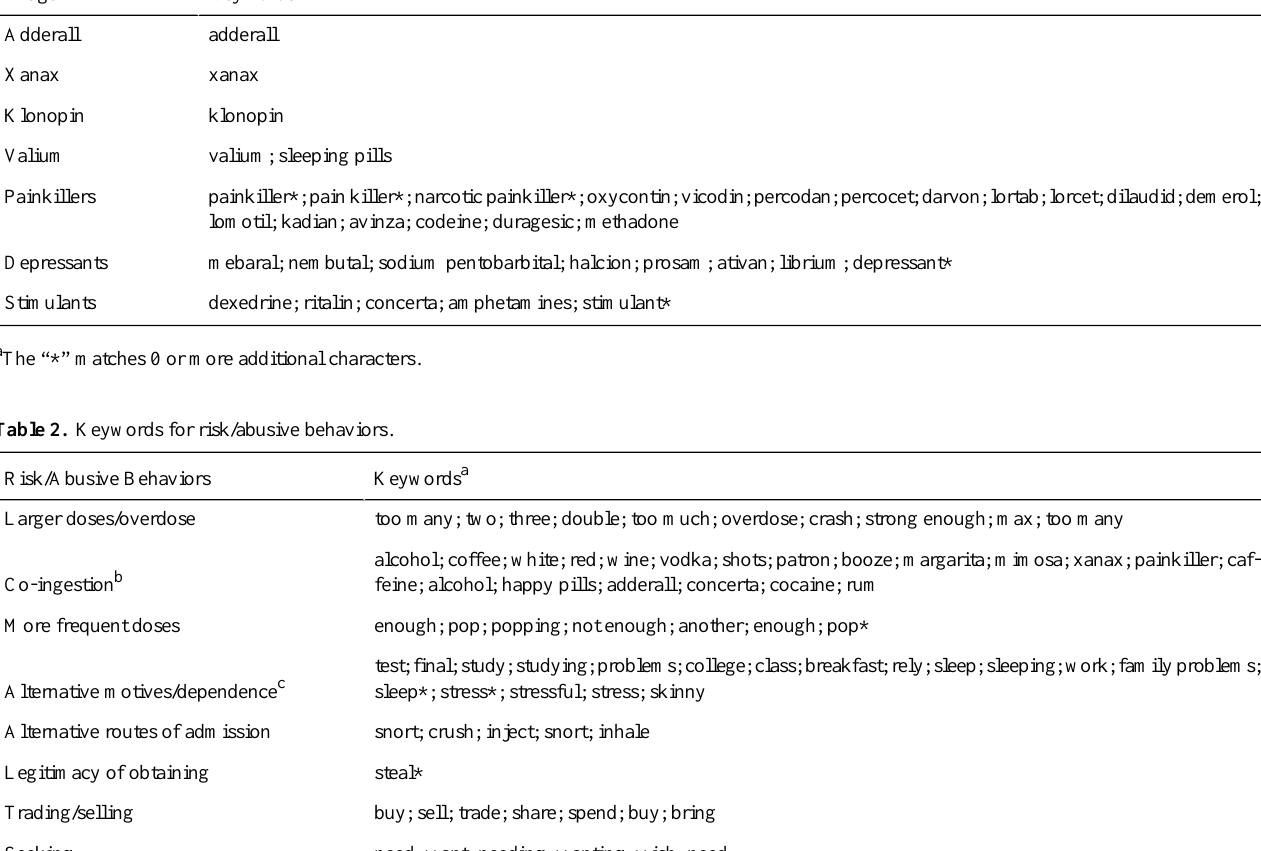
Keywords a Drugs